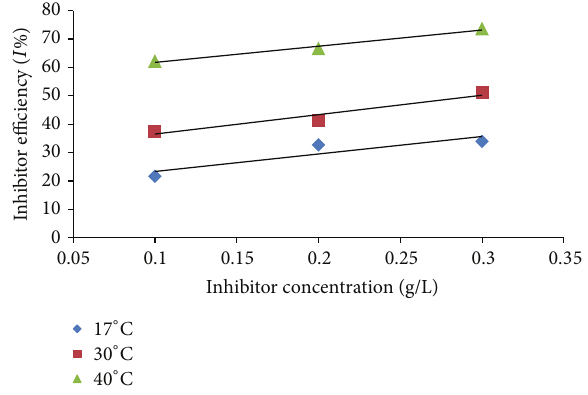
Figure 4: Inhibition efficiency of GA versus inhibitor concentration at various temperatures.